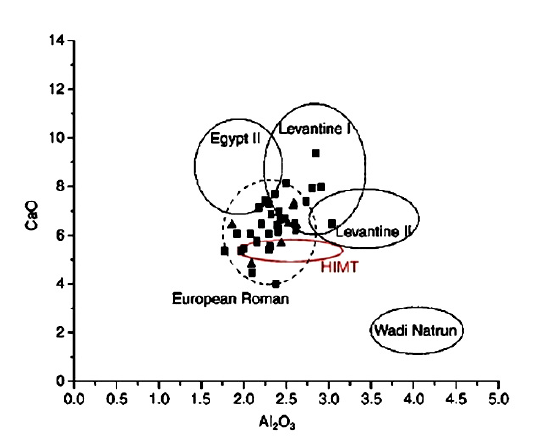
O vs CaO which discriminates some of the compositional groups of Roman glass. Modified from Figure 5: Binary graph Al 2 3 Arletti, Vezzalini, Biaggio Simona, & Maselli Scotti